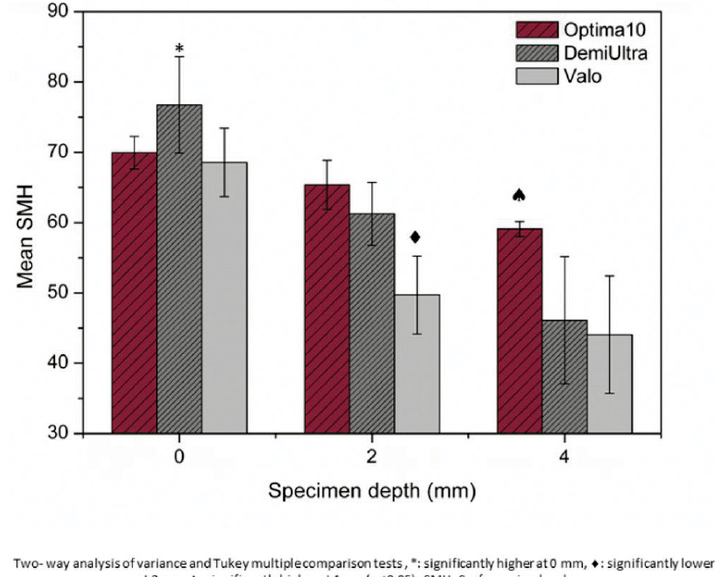
Figure 6- Surface microhardness values of samples